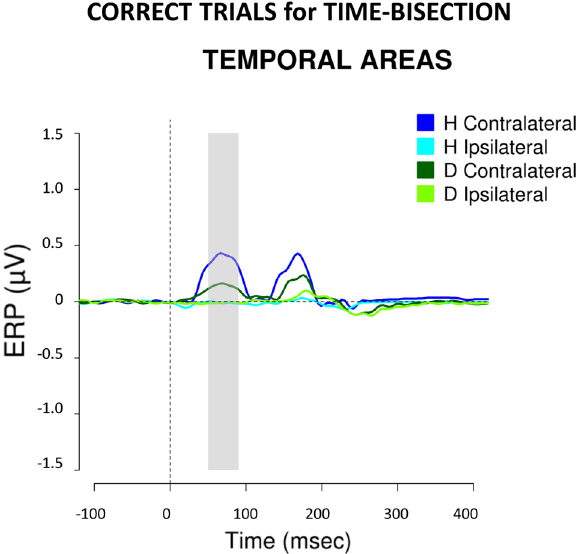
Figure 6. ERP elicited by S2 for the correct trials of the time-bisection task in temporal areas of deaf and hearing individuals. ERPs collapsed over temporal (i.e., T7/T8) scalp sites contralateral to the spatial side of S2 presentation are in dark blue and dark green for hearing and deaf groups respectively. ERPs collapsed over temporal/occipital scalp sites ipsilateral to the spatial side of S2 presentation are in cyan and light green for hearing and deaf groups respectively. On the x-axis, t = 0 is stimulus onset. The shaded area delimits the selected time window (50–90